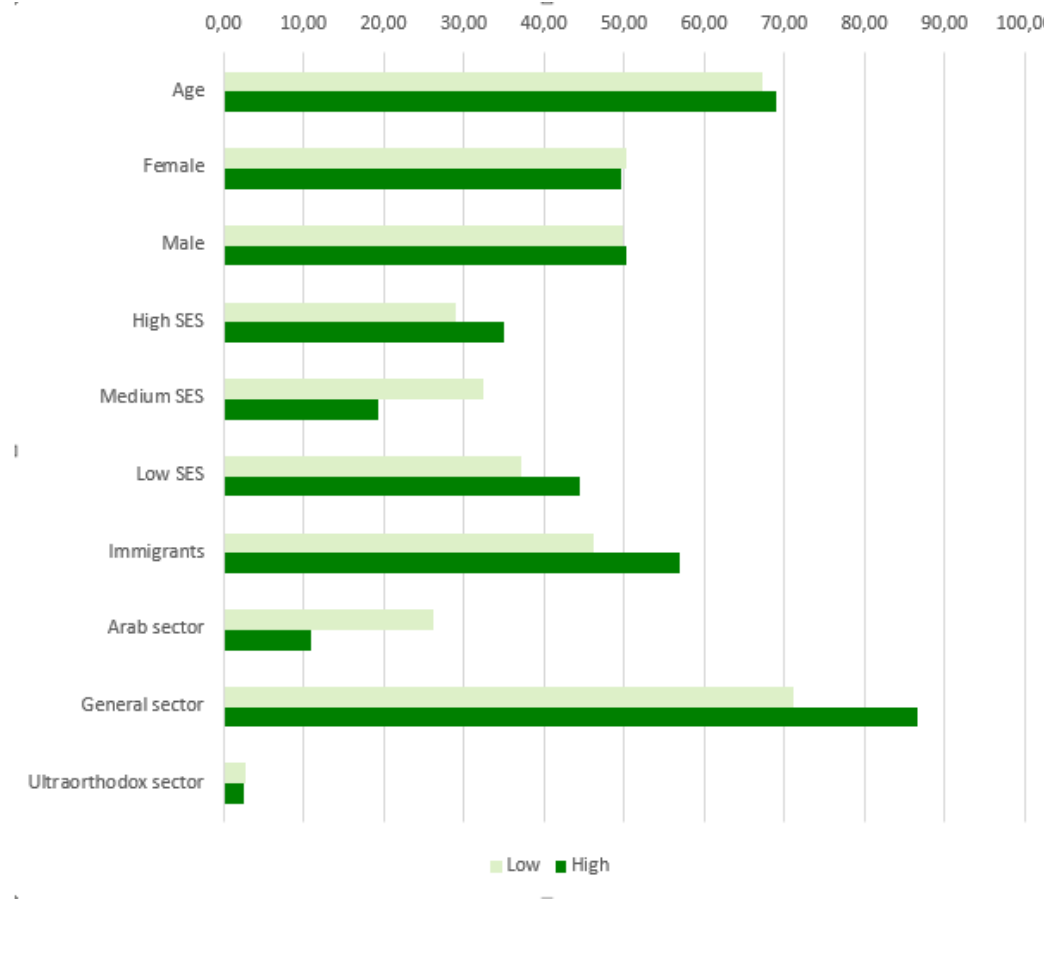
Figure 4. Differences in sociodemographic attributes between low-to-moderate and moderate-to-high health care services consumption of patients with diabetes in 2016. SES: socioeconomic